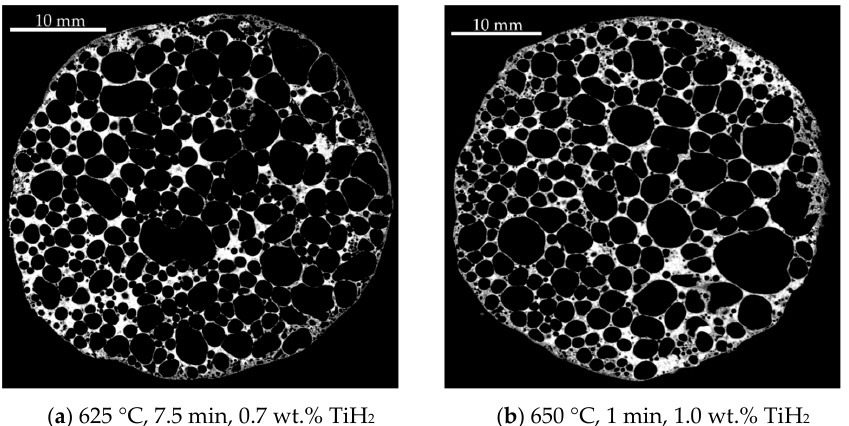
Figure 11. XRM sectional images of sample ( a ) no. 8 with foaming temperature of 625 °C, foaming duration of 7.5 min, 0.7 wt.% TiH 2 and ( b ) no. 9 with foaming temperature of 650 °C, foaming duration of 1 min, 1.0 wt.% TiH 2.